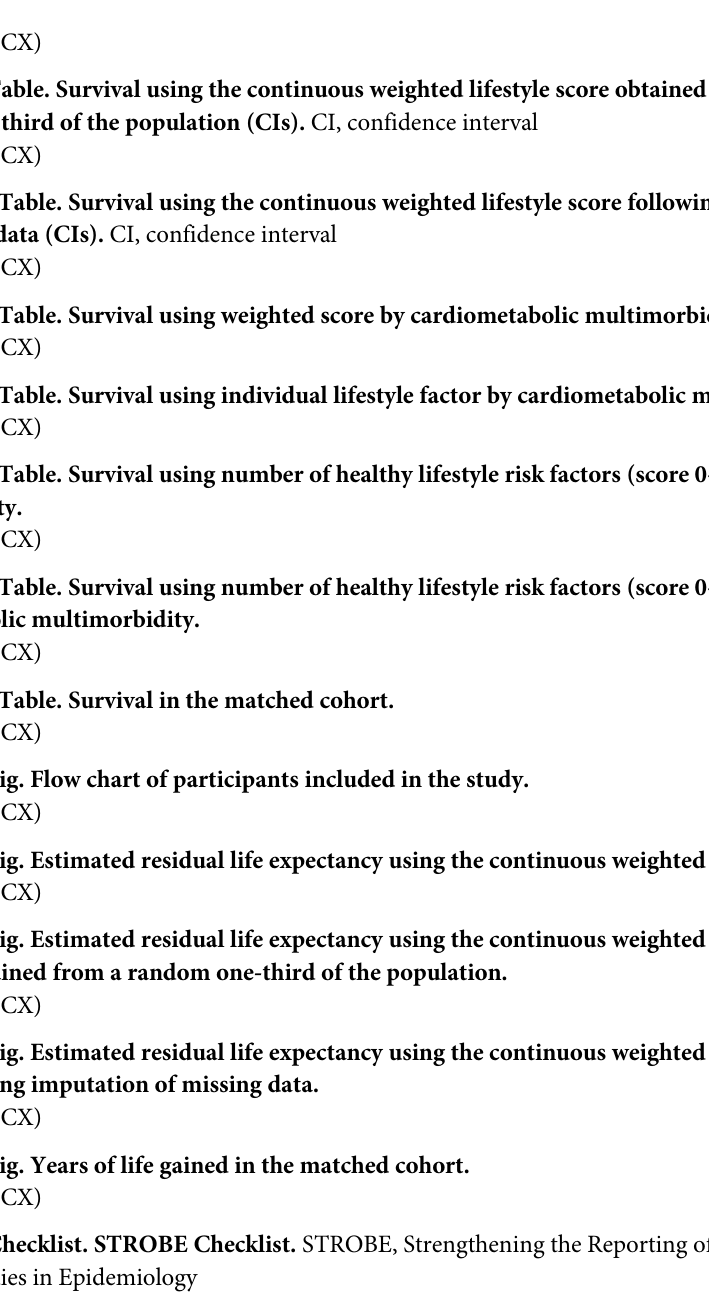
S8 Table. Survival using the continuous weighted lifestyle score (CIs). CI, confidence inter- val S9 Table. Survival using the continuous weighted lifestyle score obtained from a random one-third of the population (CIs). CI, confidence interval S10 Table. Survival using the continuous weighted lifestyle score following imputing miss- ing data (CIs). CI, confidence interval S11 Table. Survival using weighted score by cardiometabolic multimorbidity. S12 Table. Survival using individual lifestyle factor by cardiometabolic multimorbidity. (DOCX) S13 Table. Survival using number of healthy lifestyle risk factors (score 0–4) by multimor- bidity. S14 Table. Survival using number of healthy lifestyle risk factors (score 0–4) by cardiome- tabolic multimorbidity. S15 Table. Survival in the matched cohort. S1 Fig. Flow chart of participants included in the study. S2 Fig. Estimated residual life expectancy using the continuous weighted lifestyle score. S3 Fig. Estimated residual life expectancy using the continuous weighted lifestyle score obtained from a random one-third of the population. S4 Fig. Estimated residual life expectancy using the continuous weighted lifestyle score fol- lowing imputation of missing